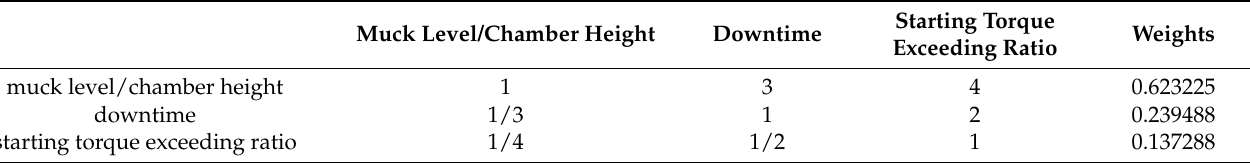
Table A6. Pairwise comparison matrix for quaternary level operational excavation mode factors